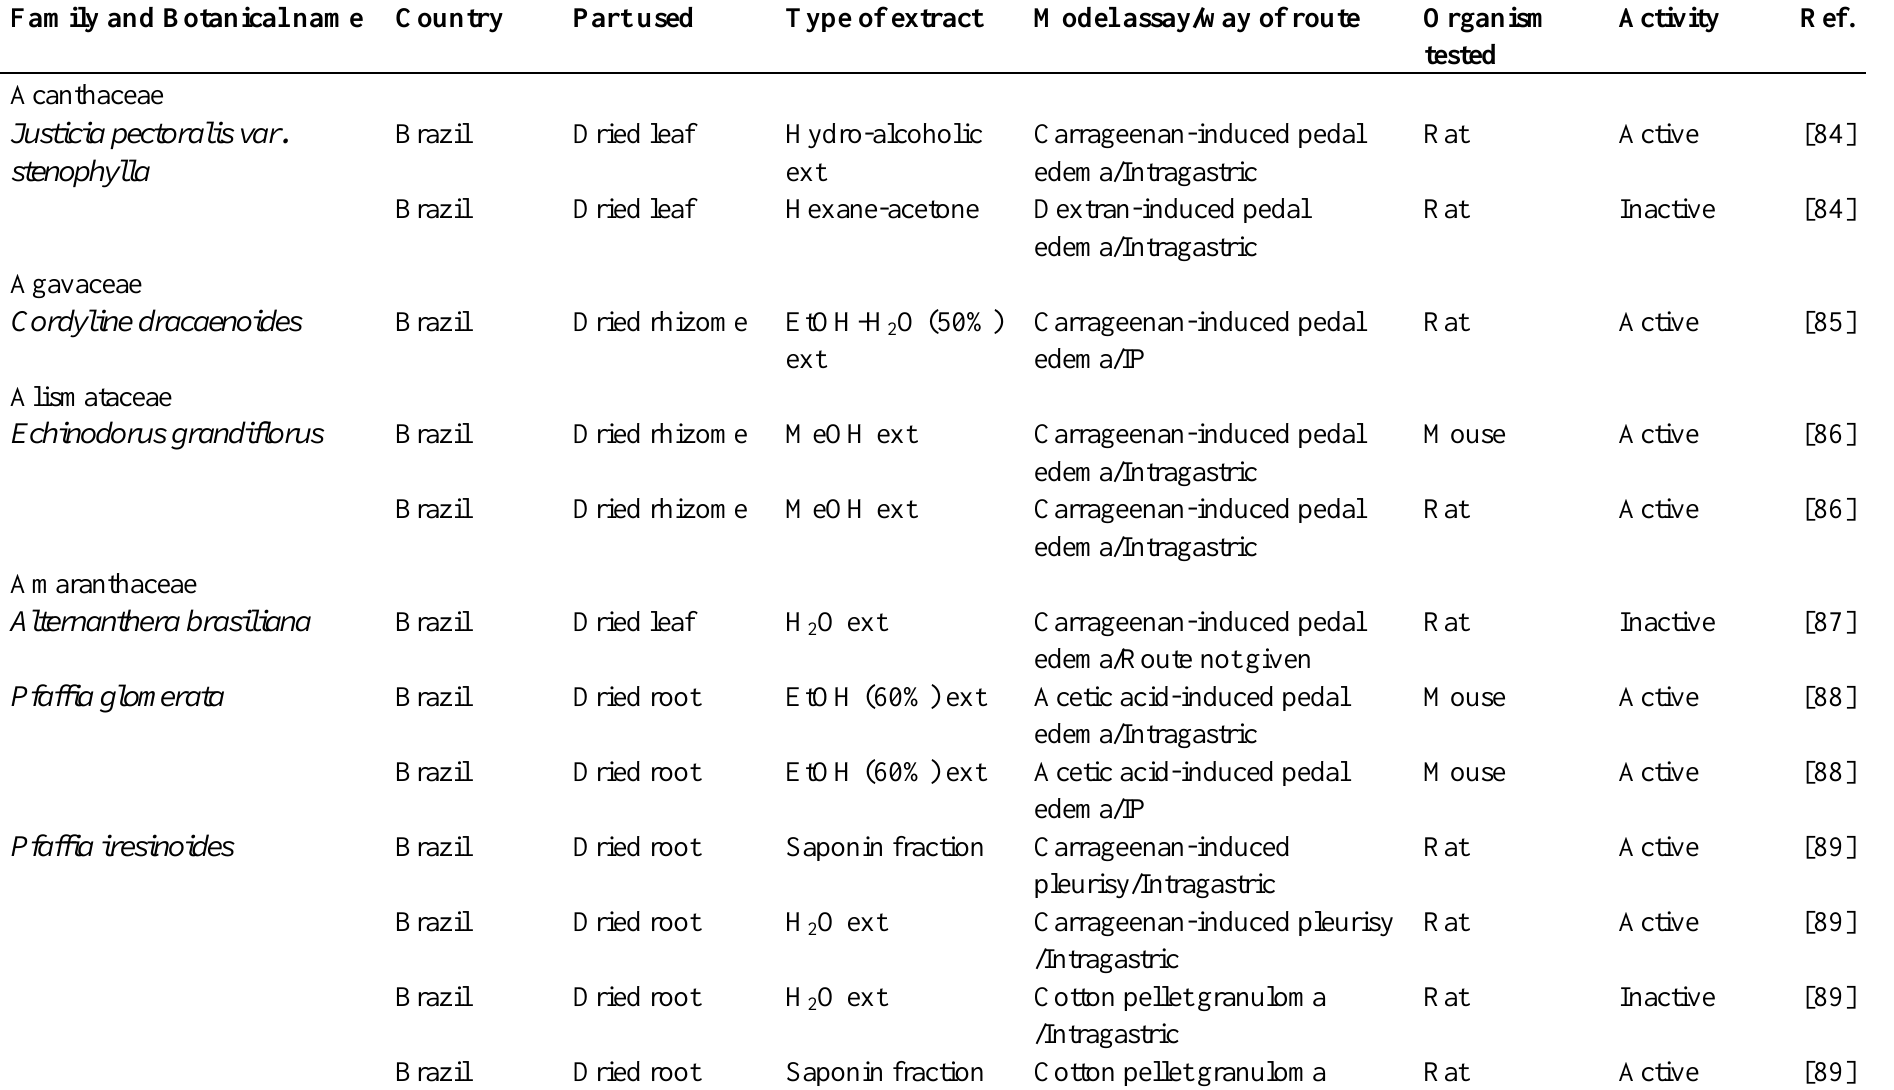
Table 1. Extracts of plants with anti-inflammatory activity studied in South